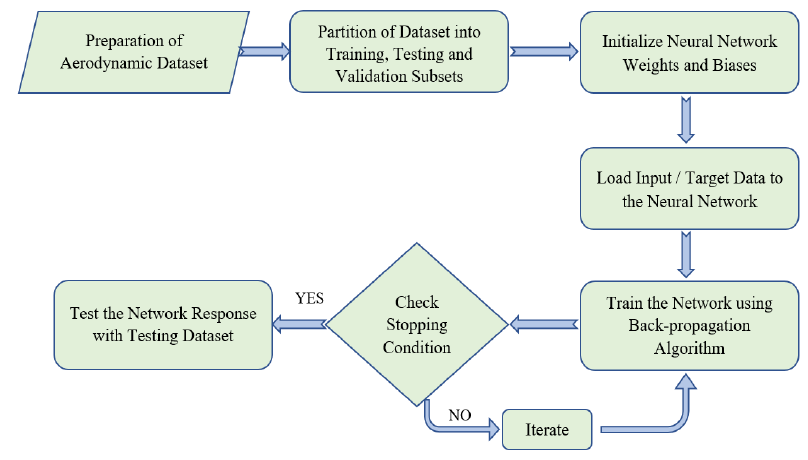
Figure 3. Building blocks of the proposed BPNN algorithm.